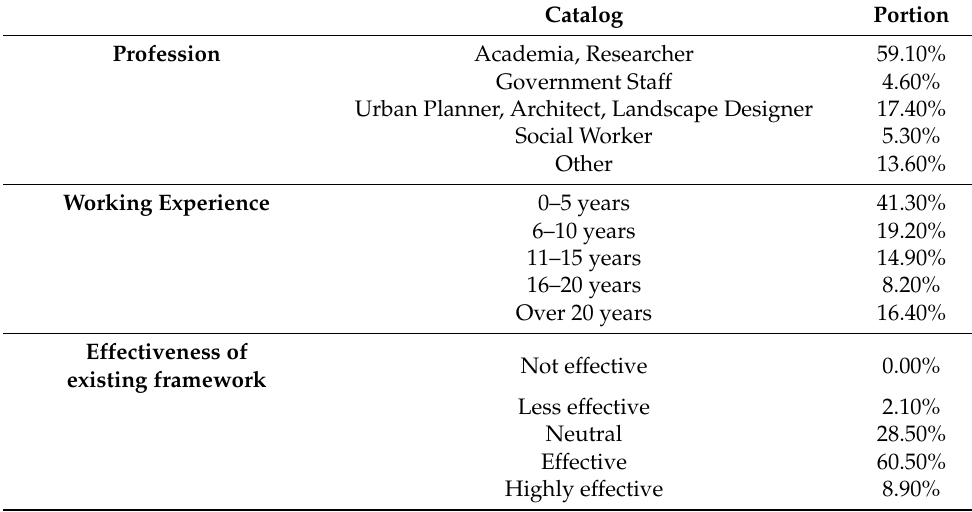
Table 1. Occupational background of the questionnaire respondents.